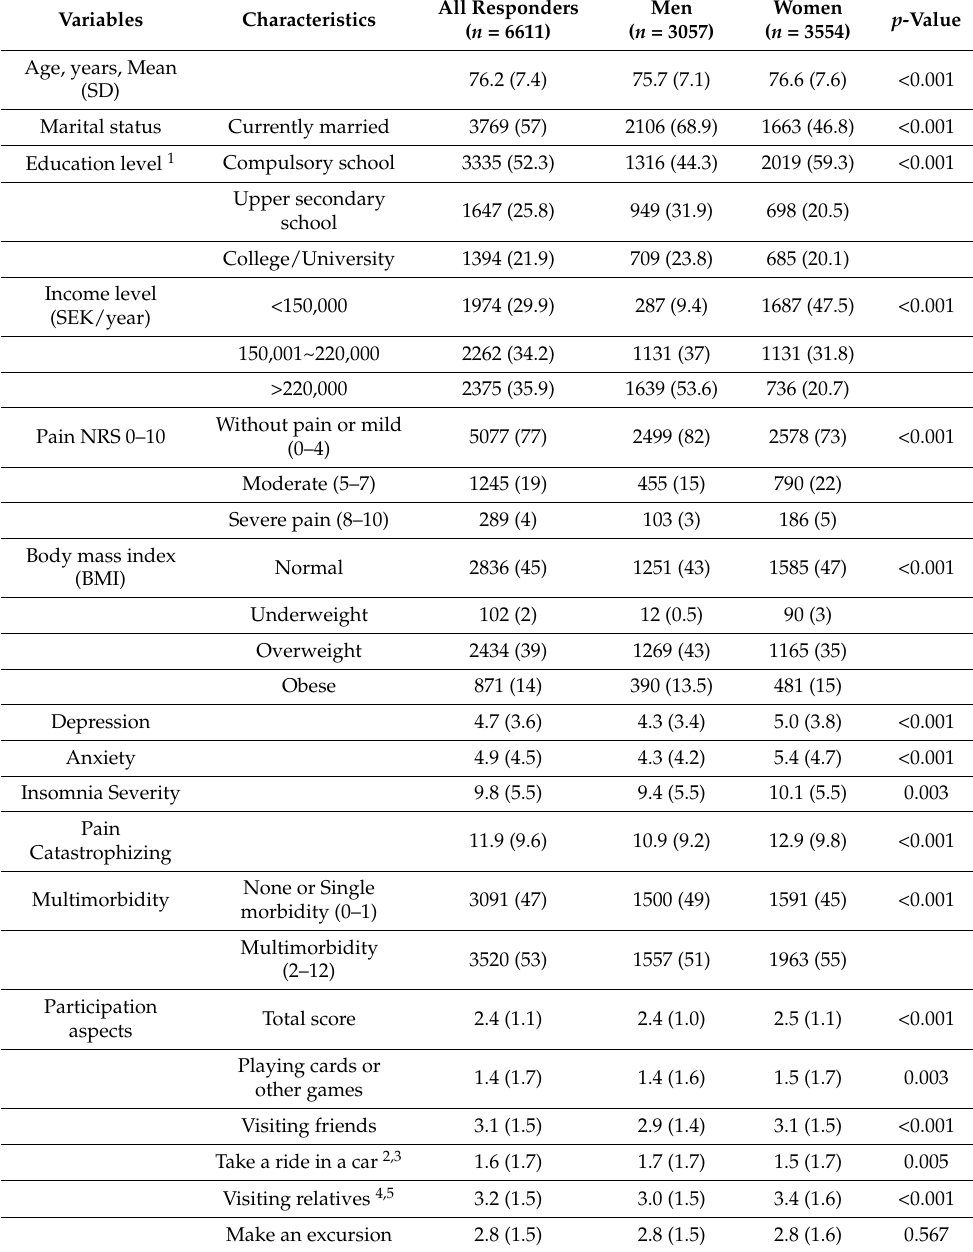
Table 1. Characteristics of the study population and stratified by